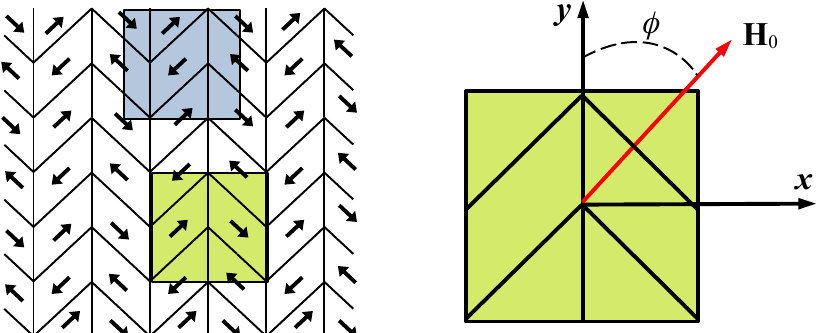
Figure 5. The structure of the twinned variant of martensite (on the left ) and domain D S containing a twin and having a certain symmetry (on the right ).